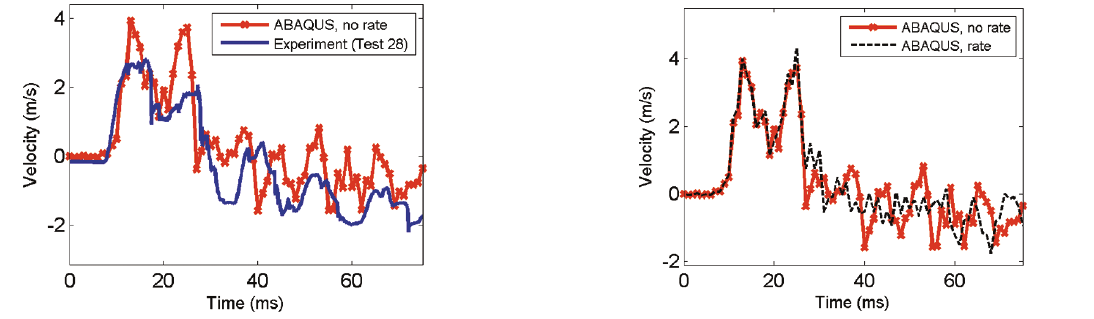
Fig. 17. Comparison between rate-independent and rate-dependent model results, dynamic tension test.